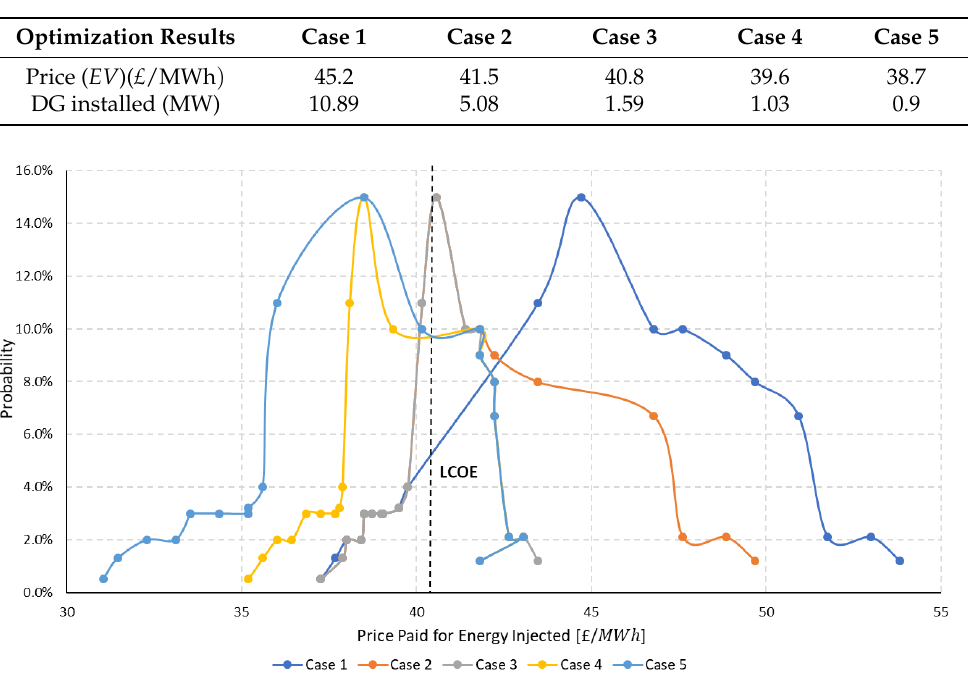
Table 4. Data of the study cases.